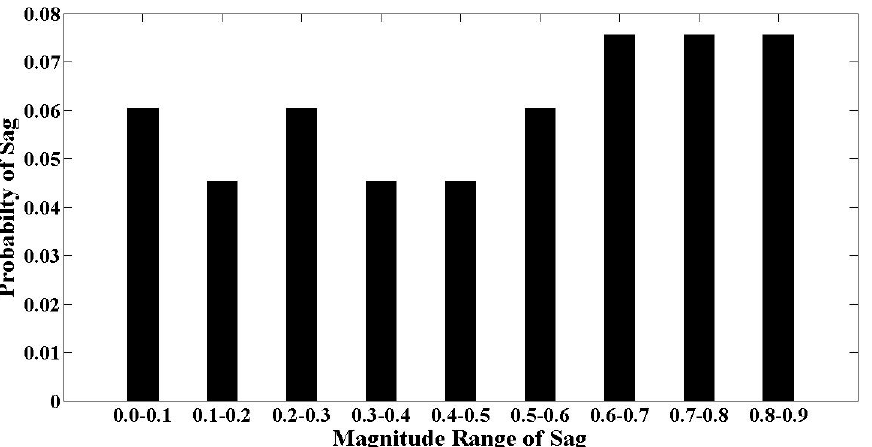
Figure 8. Joint probabilities of sag with respect to different magnitude ranges. Table 2. Variation of sag magnitude concerning the change of fault position for the duration of 80 ms.